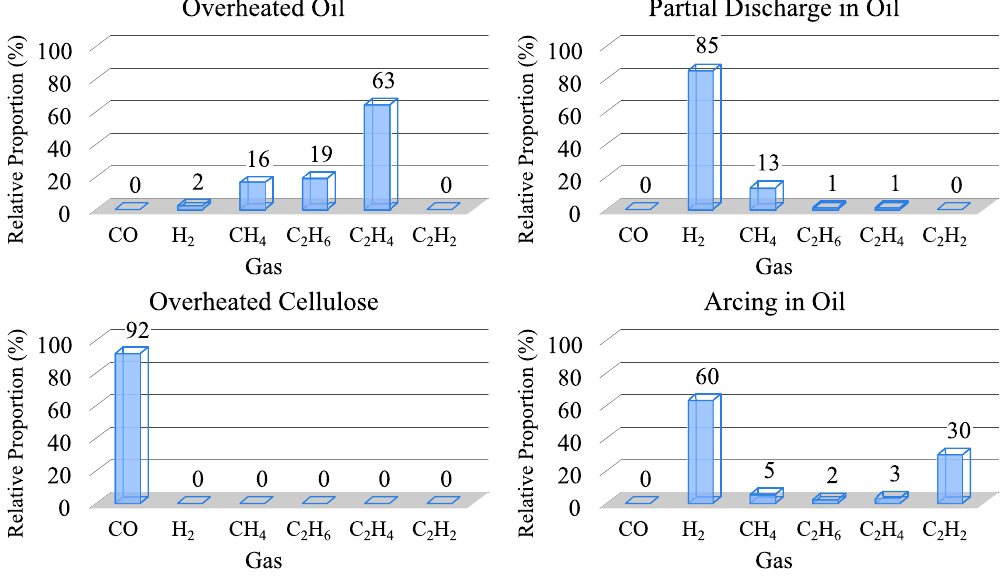
Figure 4. Fault type by the key gas method